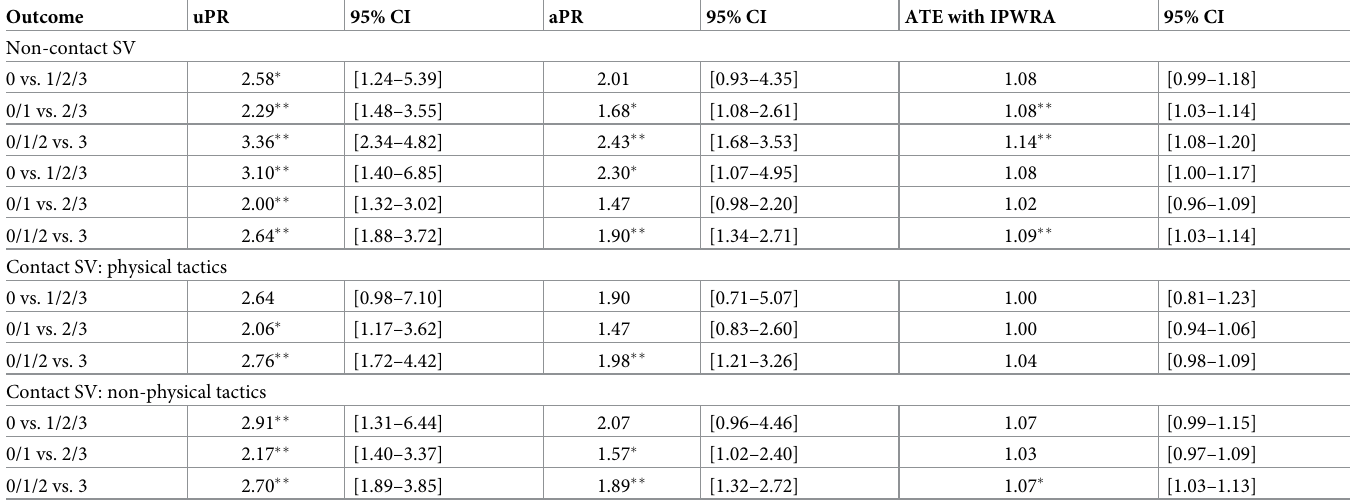
Table 2. Effect of exposure to sexually explicit material on sexually violent behavior among first-year university men in Hanoi, Vietnam (n = 735). Outcome